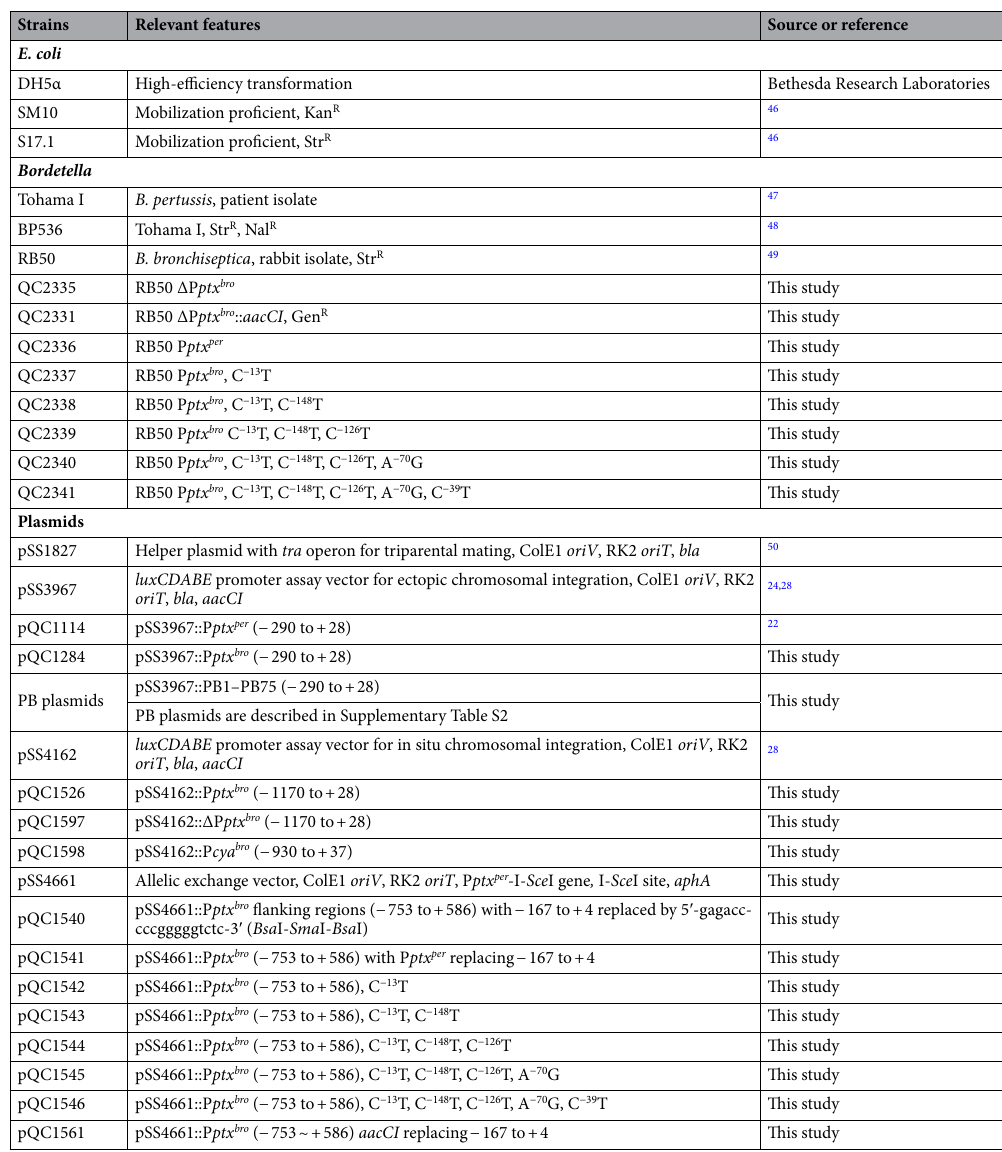
Table 1. Bacteria strains and plasmids used in this